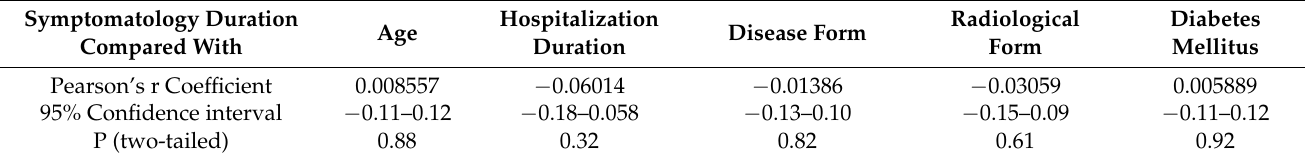
Table 3. Student’s t -test (symptomatology duration compared with age, hospitalization duration, disease form, radiological form and diabetes mellitus).